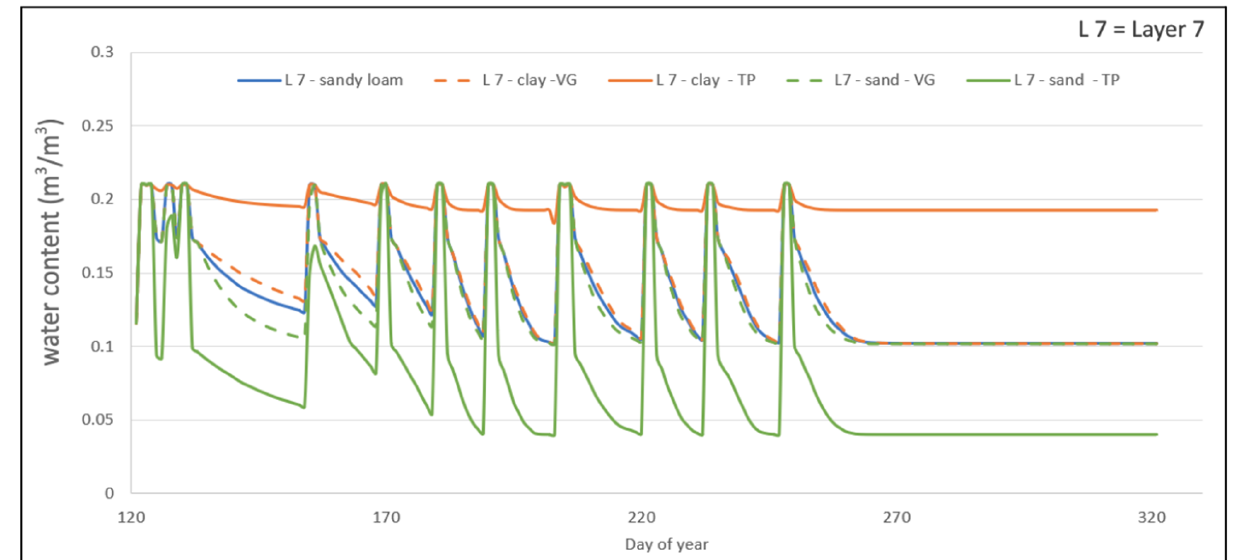
Figure 11. Sensitivity analysis for Mualem–Van Genuchten parameters (middle dashed lines), and tipping bucket parameters (FC and WP) (outer solid lines) for FT (FAO crop coe ffi cient curve) treat- ment.